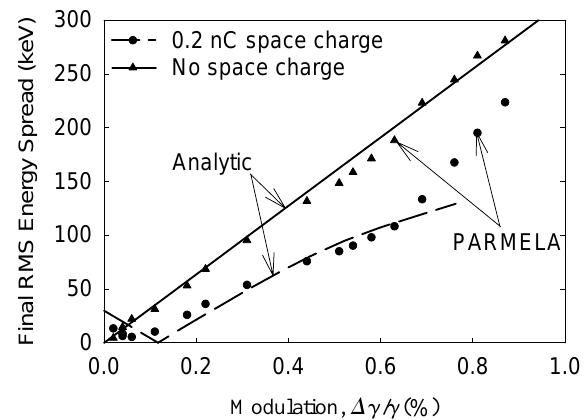
FIG. 5. Comparison between the analytic model and PARMELA code simulations of the final rms energy spread.